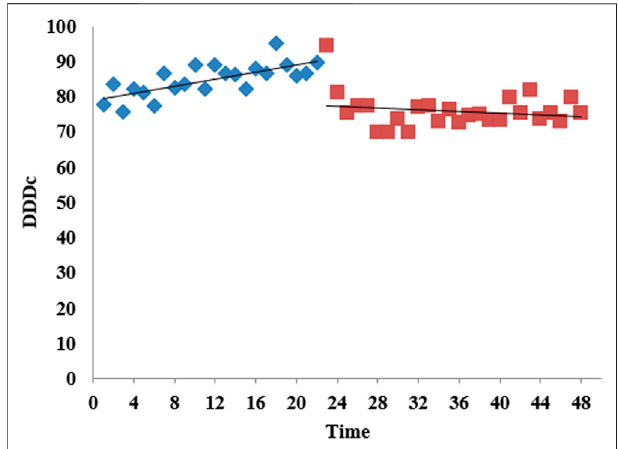
FIGURE 7 | The economic burden of residents using carbapenem agents in Shaanxi Province, 2017 – 2020.